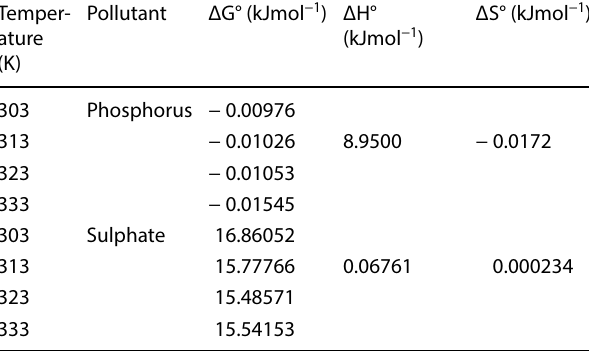
Table 8 Summary of thermodynamic